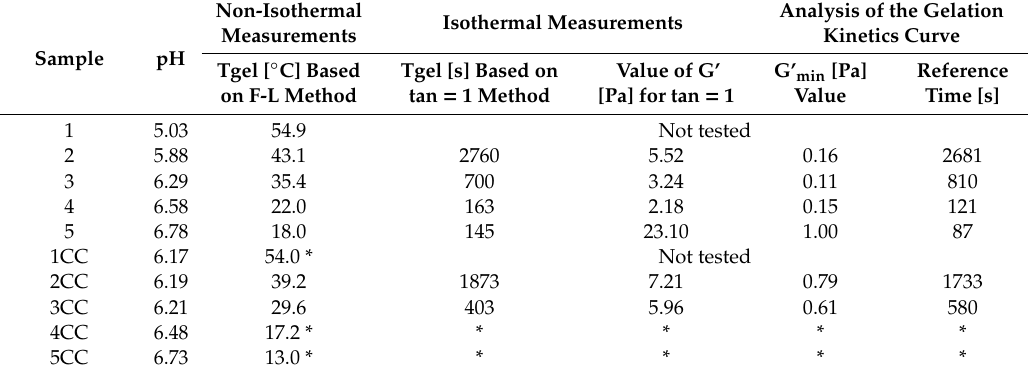
Table 2. Results of non-isothermal and isothermal measurements for the tested samples and analysis of the gelation kinetics